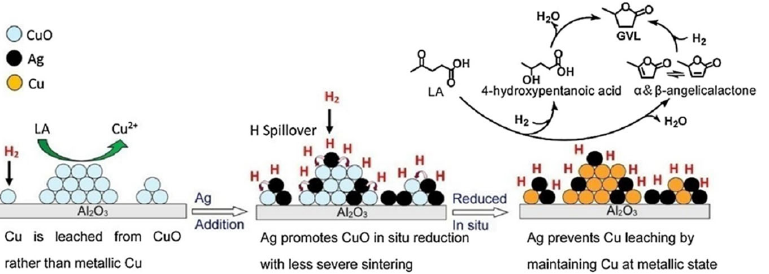
Figure 5. Schematic of the proposed mechanisms of in situ reduction and metal leaching prevention and the reaction pathway. Reprinted with permission from [175]. Copyright 2018 Elsevier.